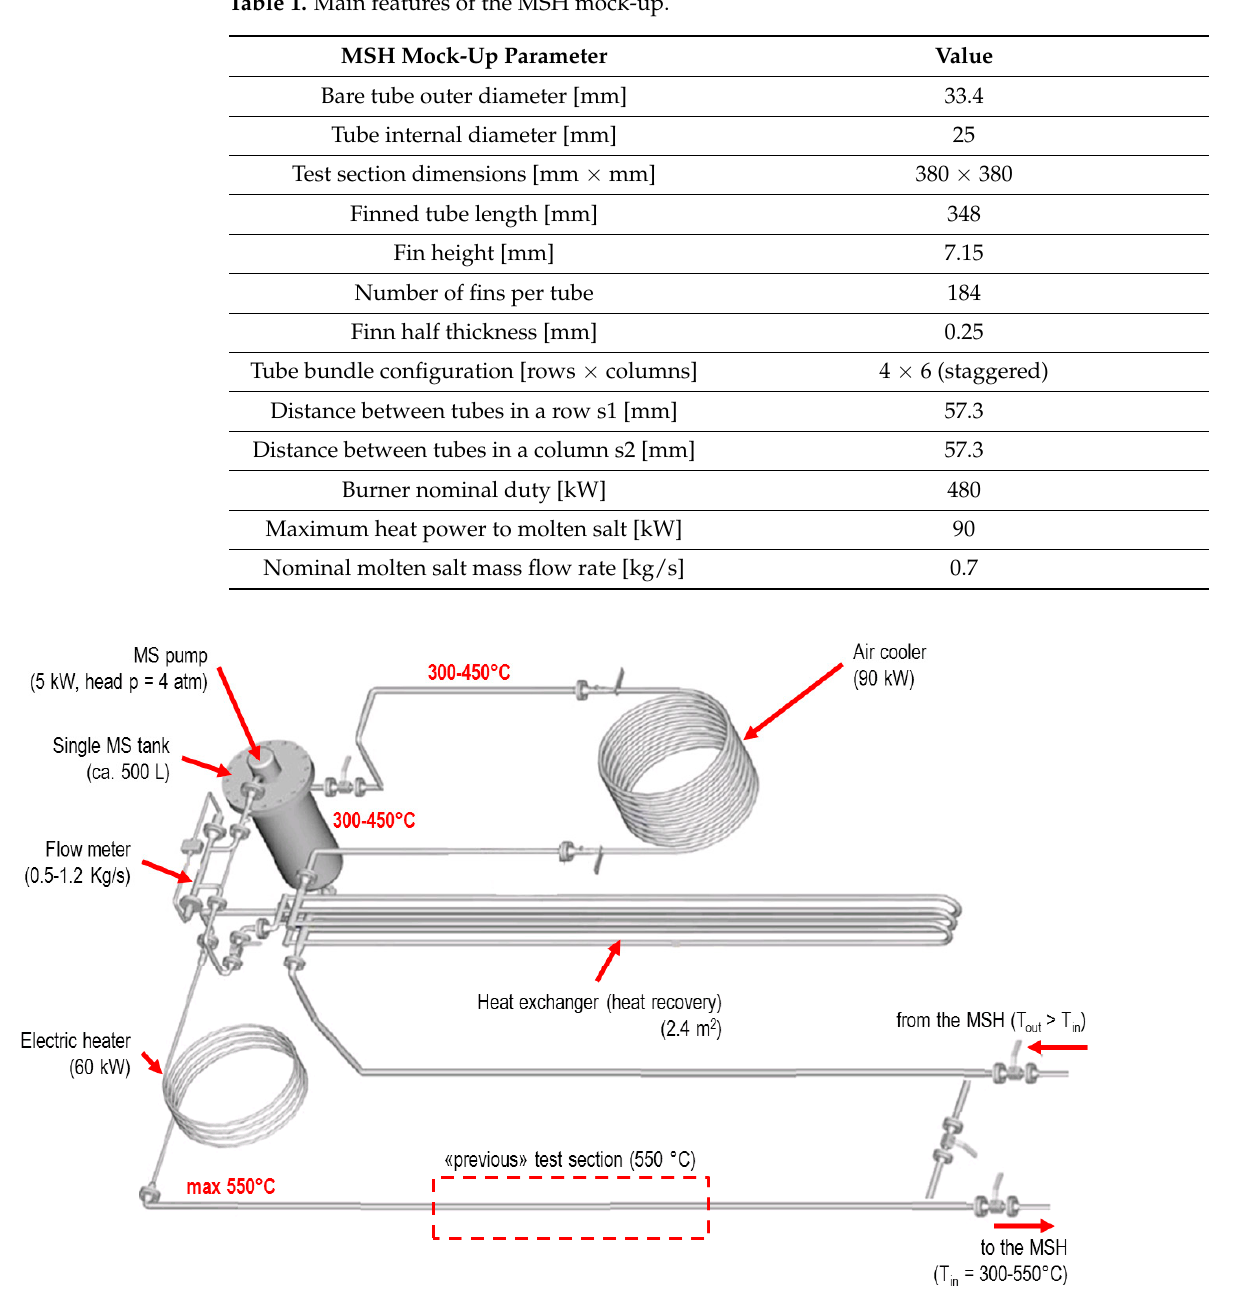
Figure 2. General scheme of the MoSE loop at ENEA-Casaccia adapted for the installation of the MSH mock-up. Table 1. M ain features of the MSH mock-up.